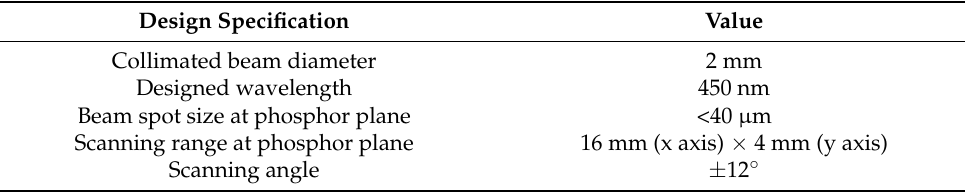
Table 1. Optical specification considered in design of laser diode scanner headlamp.